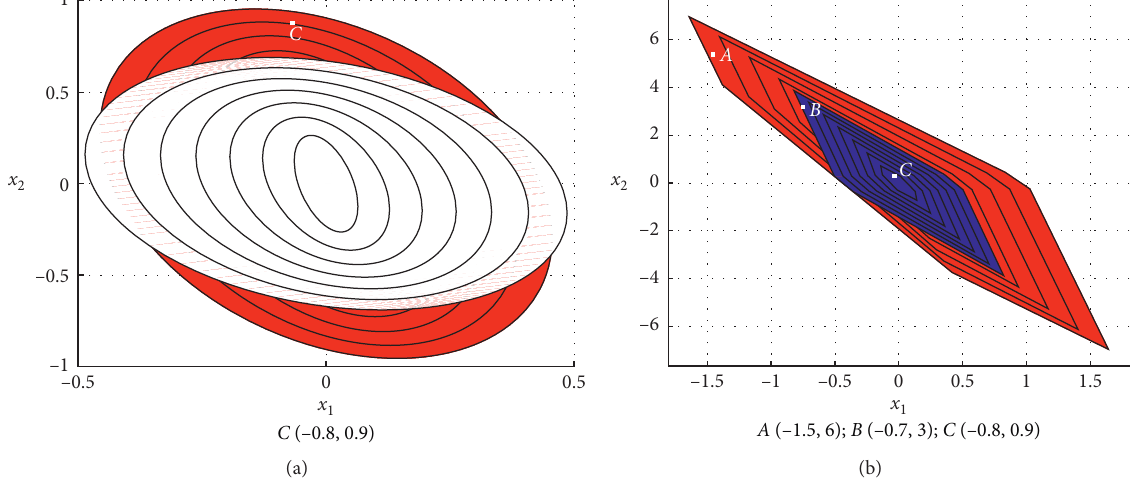
Figure 7: (a) Maximized ellipsoidal invariant sets compared to [15] and (b) maximized polyhedral invariant sets compared to [18].